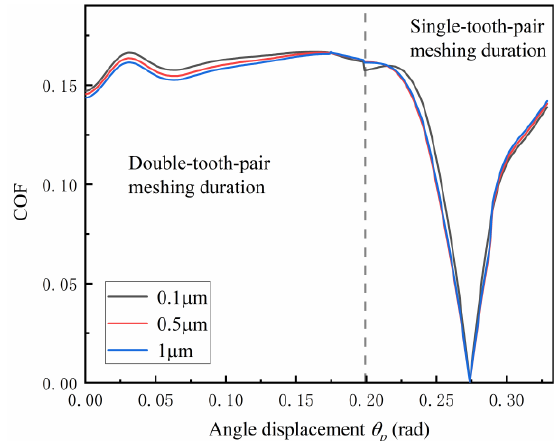
Figure 8. Gear mesh force 𝐹 (𝑚) of gear system under different wear severities.